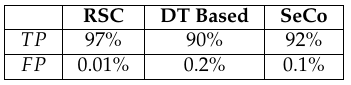
Table 10. TP and FP